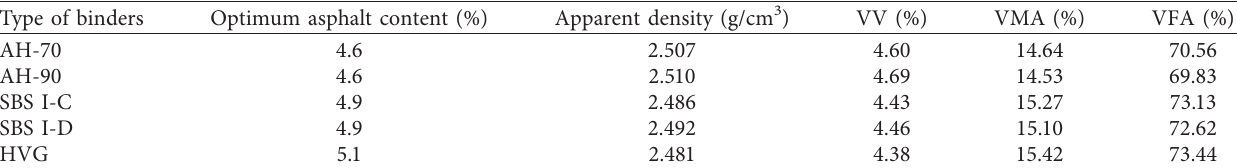
Figure 1: Grading curve. Table 4: Result of Marshall test.